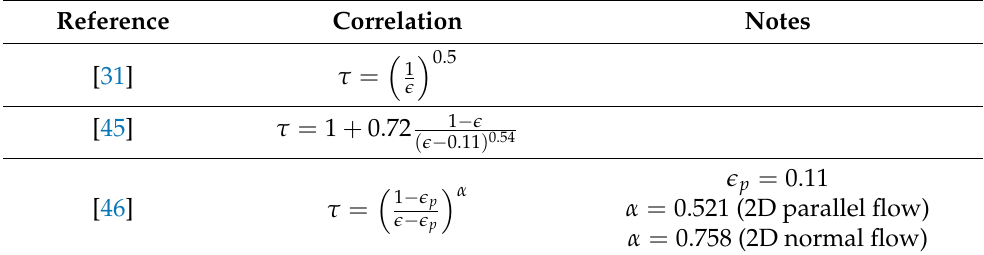
Table 5. Correlations for gas diffusion layer (GDL) tortuosity τ